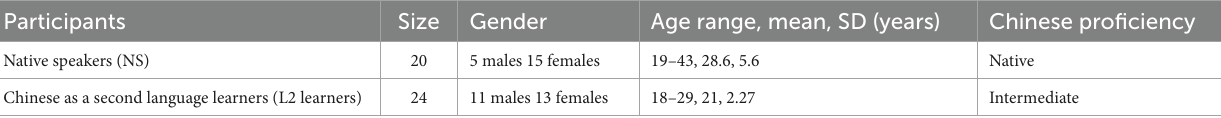
TABLE 1 Demographic information for